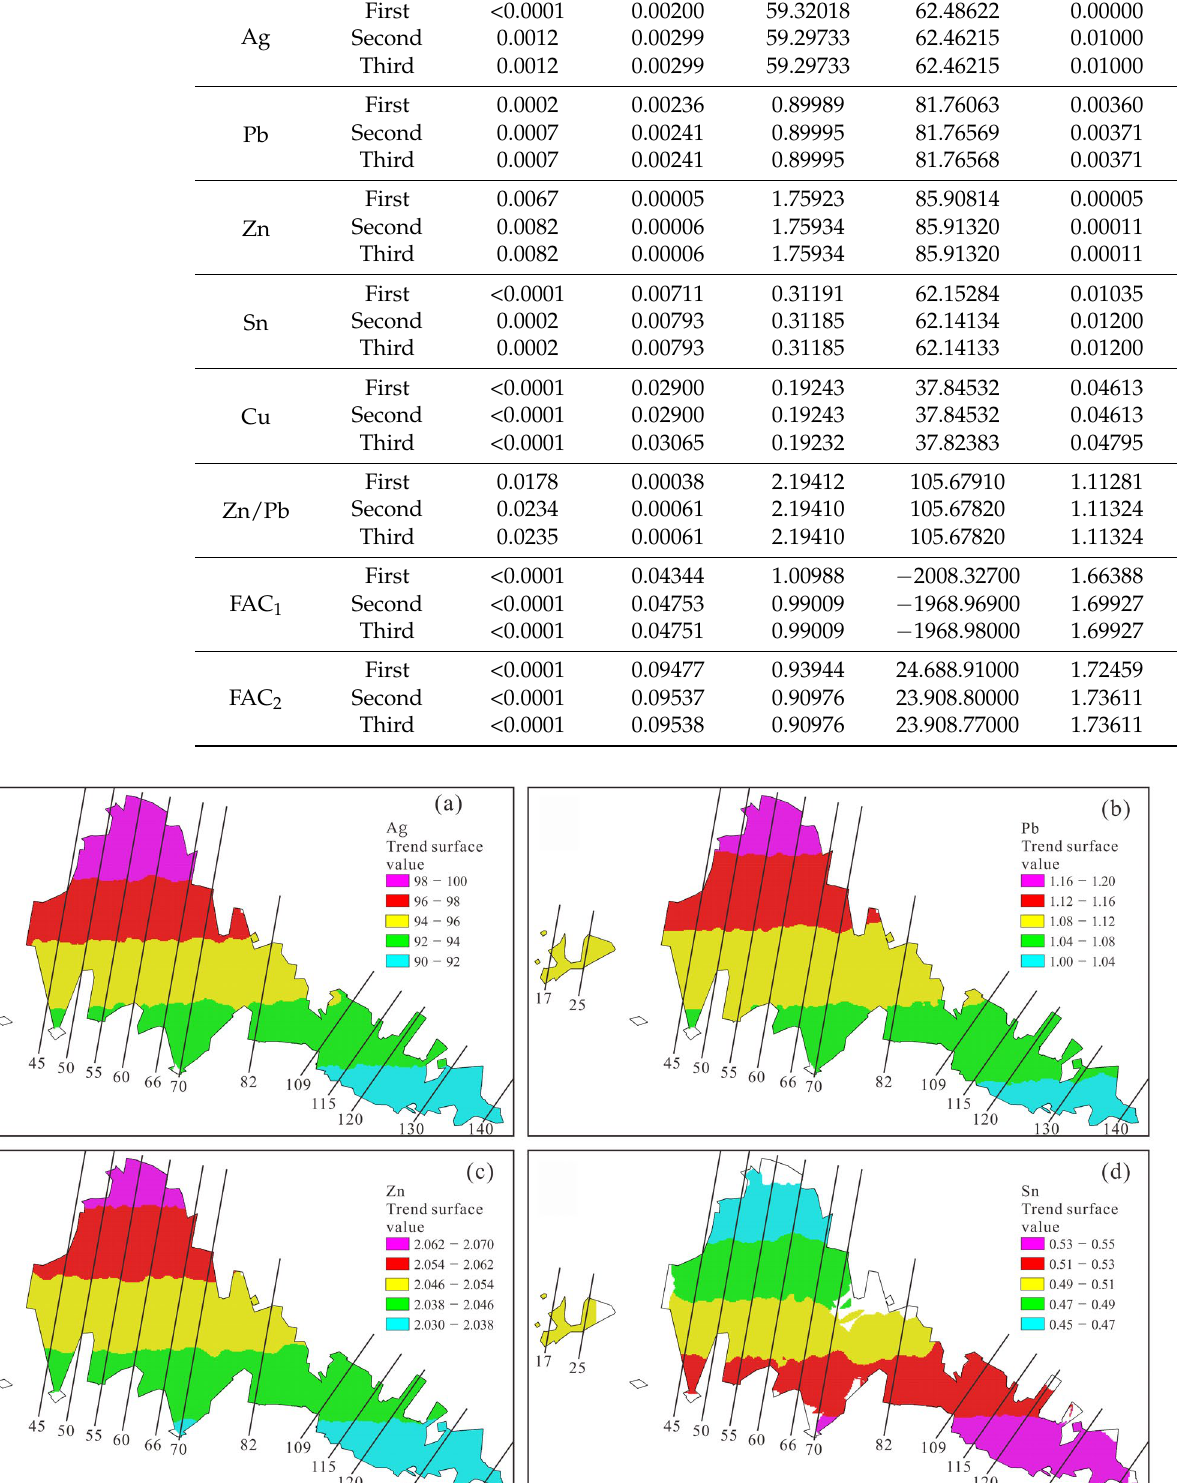
Figure 11. Horizontal projection of the ore body and the first-order trend surface of the mineralization: ( a ) Ag; ( b ) Pb; ( c ) Zn; ( d ) Sn; ( e ) Cu; ( f ) Zn/Pb; ( g ) FAC 1 = medium-temperature factor score; ( h ) FAC 2 = high-temperature factor score. The first-order trend plane shows the grade trend contours for each element are distributed in a nearly E–W direction, with Ag, Pb, Zn, Cu and FAC 1 being weak in the south and strong in the north, and Sn, Zn/Pb values and FAC 2 being high in the south and low in the north. In general, the mineralization is enriched in Sn (high-temperature